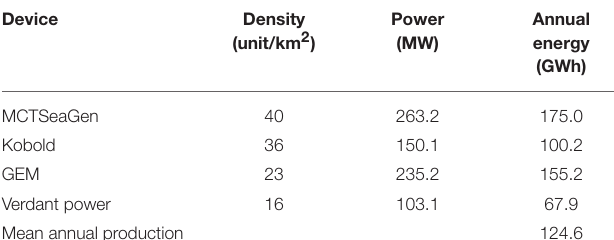
TABLE 2 | Annual energy production assessment according to selected current turbines-Method of farms.